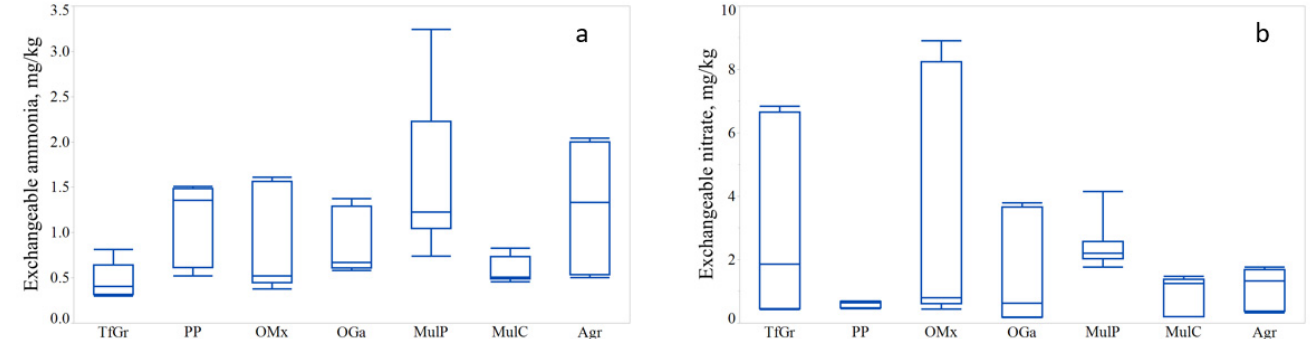
Figure 3. Exchangeable soil ammonium ( a ) and nitrate ( b ) in the landscape patches. Values are on a whole-core basis. Agr; remnant agricultural field, TfGr; turfgrass, PP; perennial peanut, OMx; patch with a mixture of ornamental grasses, OGa; patch with gamma grass, MulP; patches with pine needle mulch, MulC; patch with pine bark nuggets.